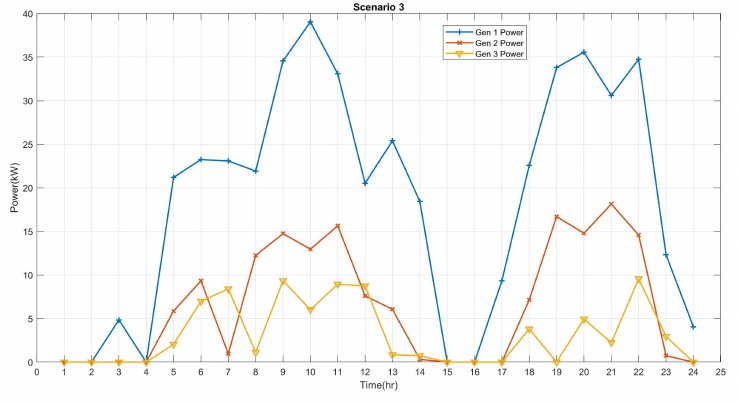
Figure 10. Generator power dispatched in Scenario 3.